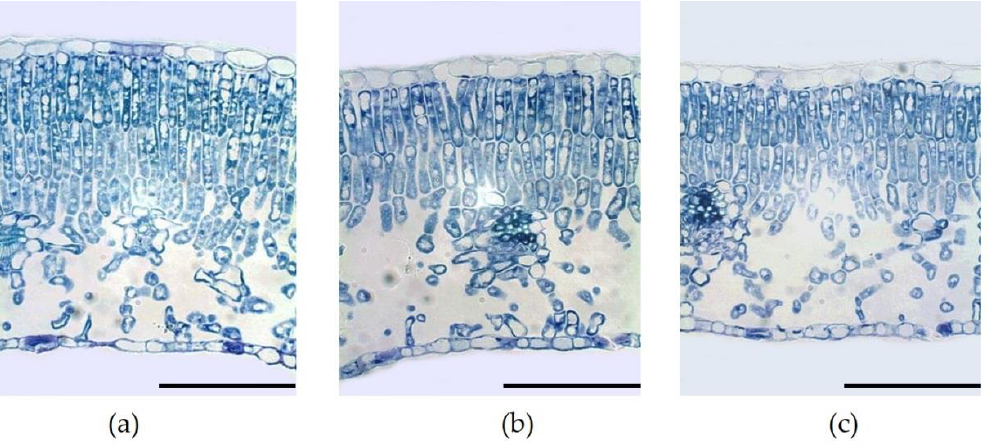
Figure 4. ( a ) Leaf cross-section of ‘Fuji’ mature apple leaves grown under white (control), ( b ) red and ( c ) blue nets. Magnification 40 × . Bars = 100 µ m. Table 3. The influence of red and blue netting on leaf mesophyll characteristics in ‘Fuji’ apple trees. Net